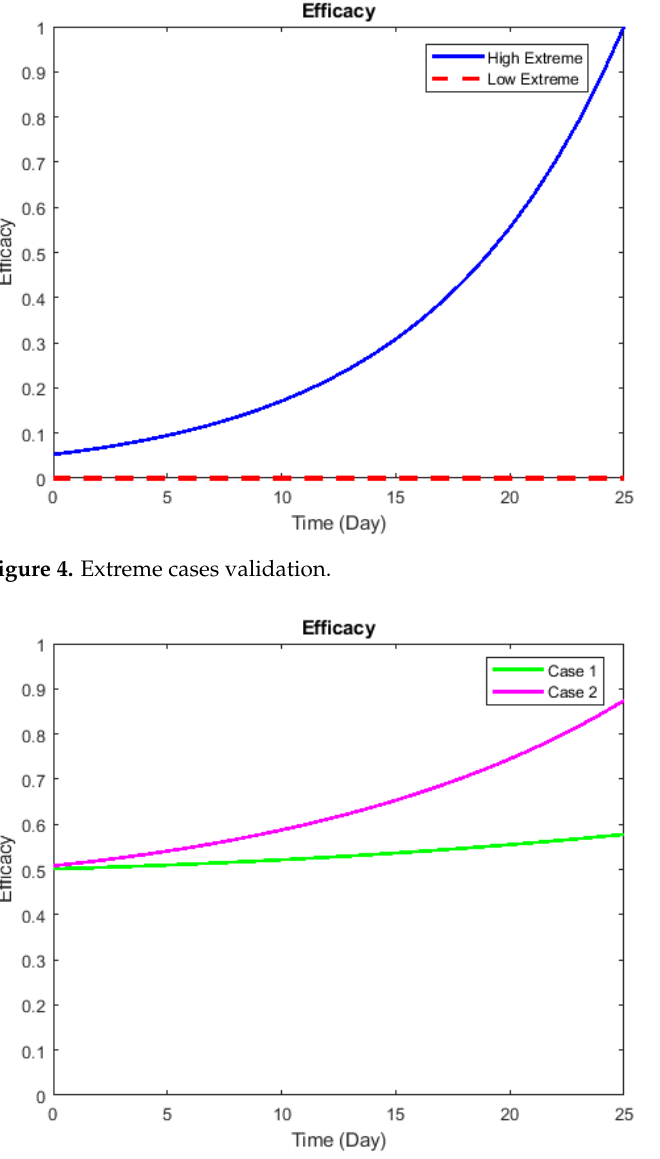
Figure 5. Simulation validation of two case